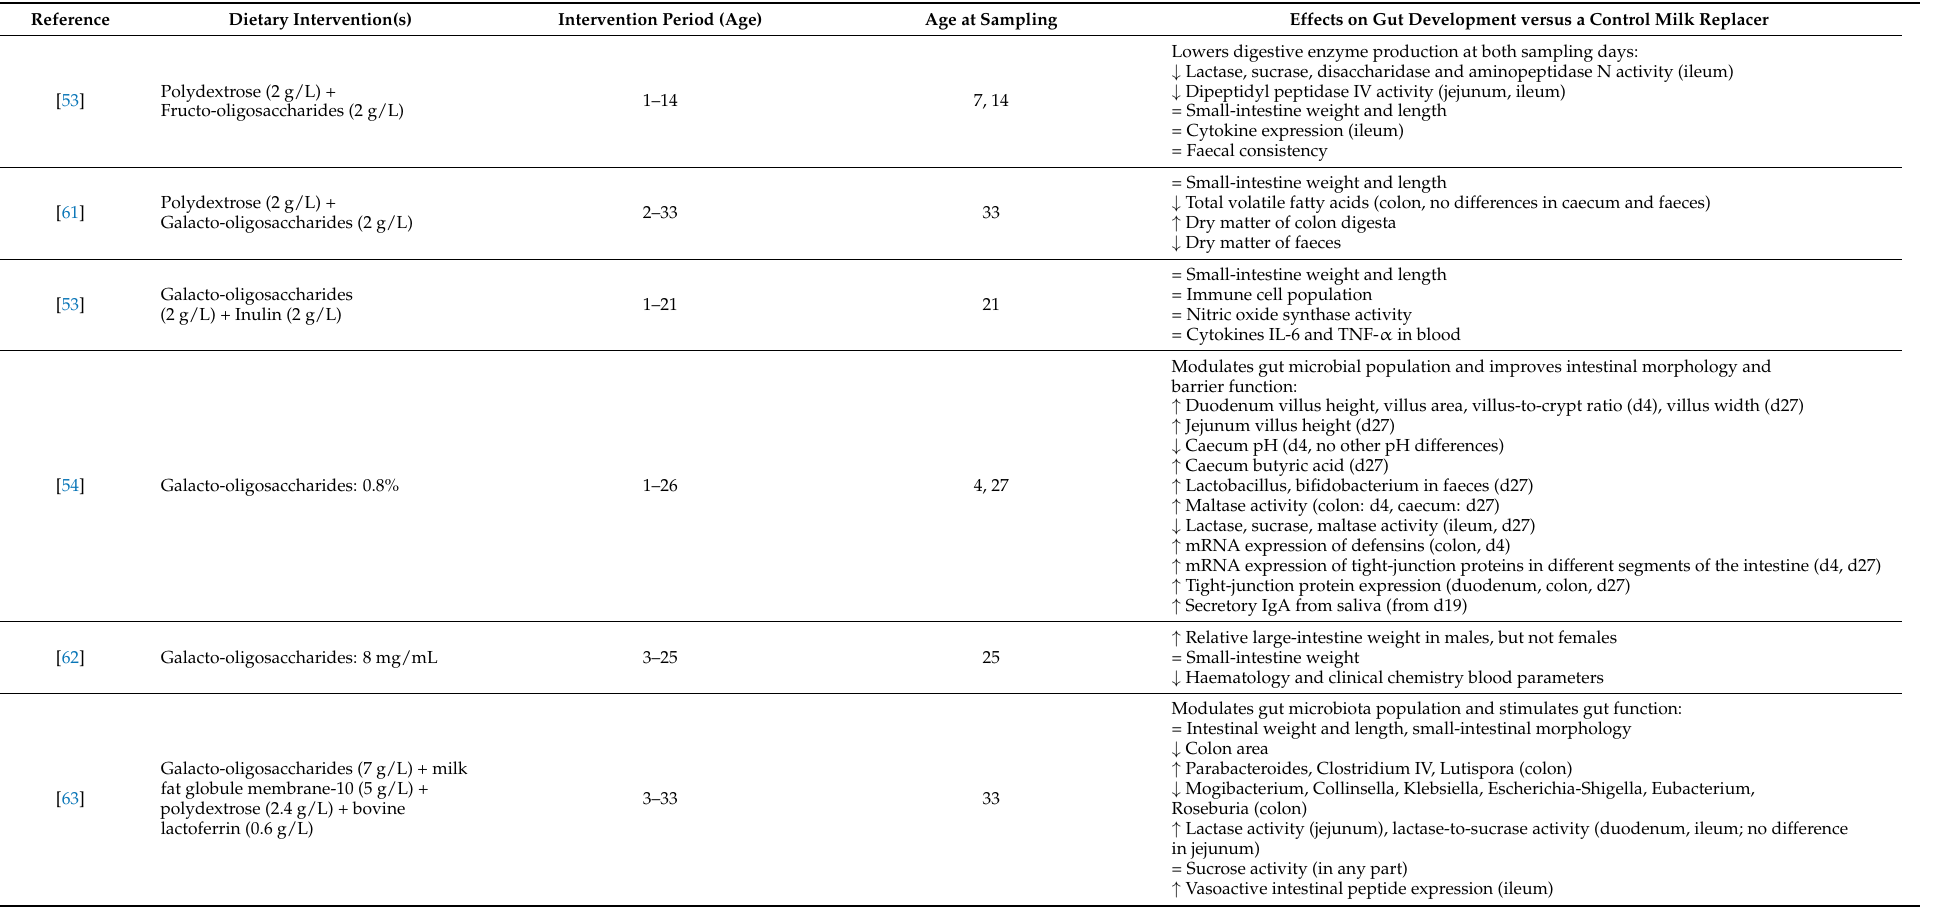
Table 2. Effects of pre-weaning dietary interventions in milk replacer on the gut development of artificially reared piglets. ↓ Significant decrease at p < 0.05; ↑ Significant increase at p < 0.05; = No significant difference; BW = body